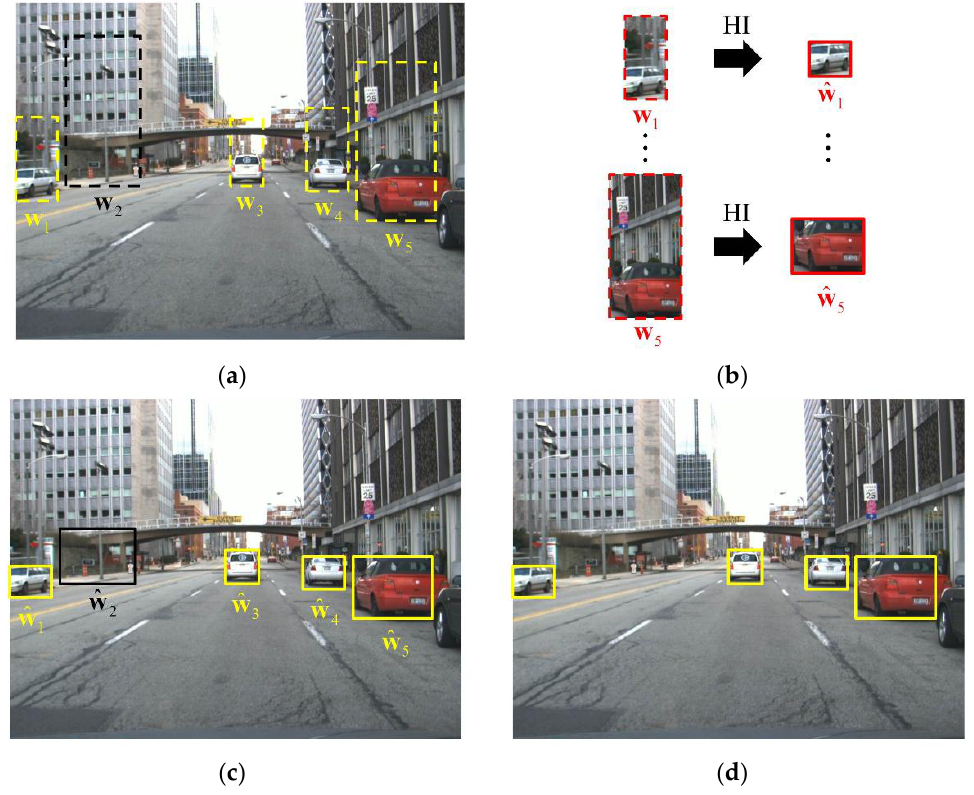
Figure 4. The framework of the proposed method: ( a ) shows the result of the HG by signed horizontal edges p h i “ 2 w i q ; ( b ) is the result of the estimation of the vehicle height; ( c ) shows the hypothesized windows given as the result of the HI; and ( d ) shows the vehicle detection results in the HV.